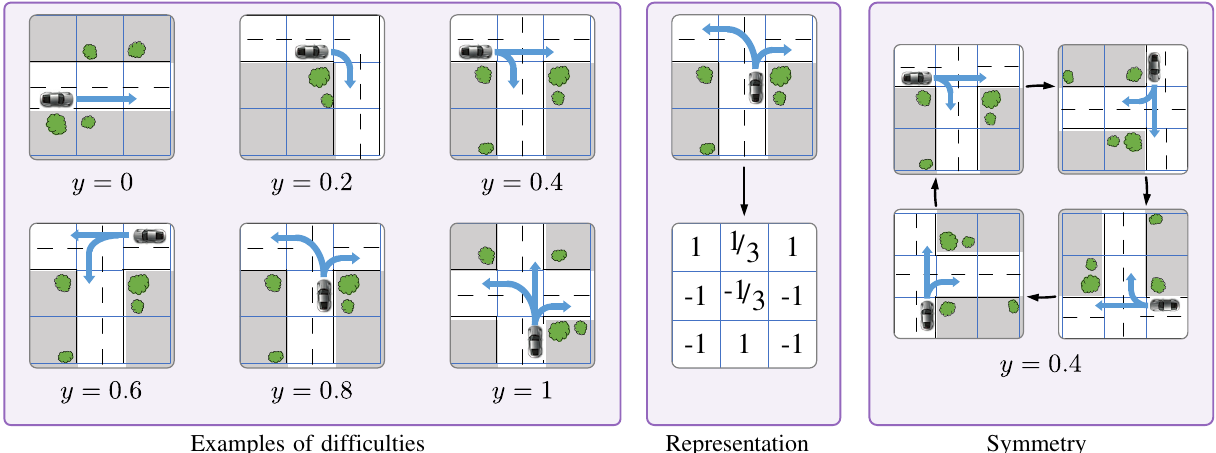
FIG. 6. Examples of the various difficulties encountered in the autonomous driving toy model (left), a demonstration of the data representation (middle), and a demonstration of the rotational symmetry of the model